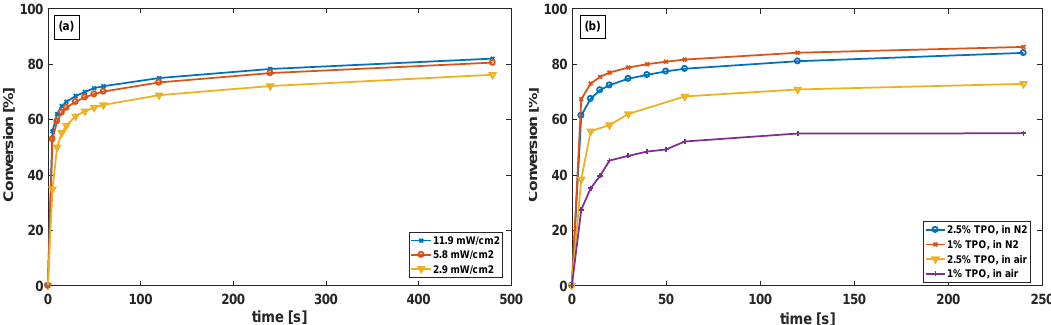
Figure 4. Monomer conversion of 1,3-AOBAE. In ( a ) monomer conversion of AOBAE films with 2.5 wt % TPO for different curing power/cm 2 in N 2 atmosphere, 2.9, 5.8 and 11.9 mW/cm 2 . ( a ) shows that monomer conversions for 5.8 and 11.9 mW/cm 2 are quite comparable and 2.9 mW/cm 2 a bit lower. In ( b ) the effect of TPO concentration, 2.5 and 1 wt %, on the monomer conversion in AOBAE film is shown. This shows that while in N 2 atmosphere, the difference is negligible, which is clearly different from when curing is carried out in